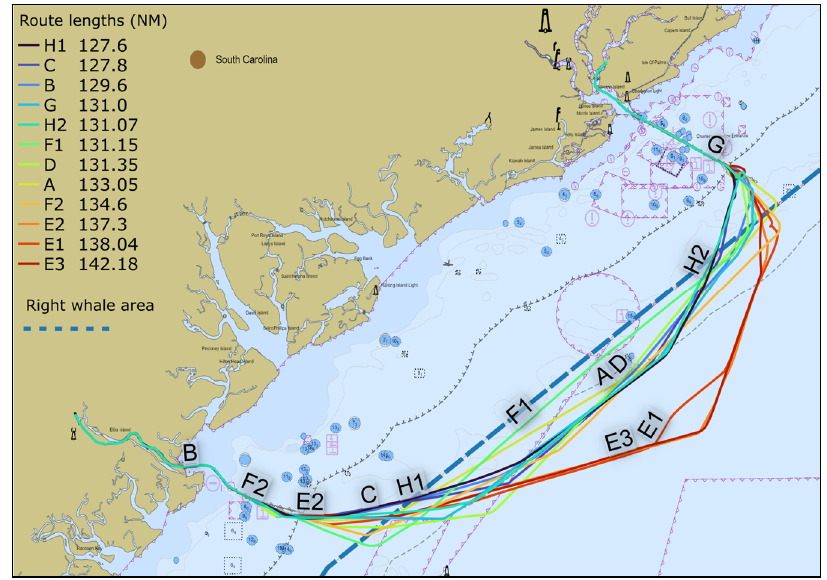
Figure 7. Route lengths for individual ships and voyages (scale 1:600000). Dashed line represents right whale Seasonal Management Area boundary.